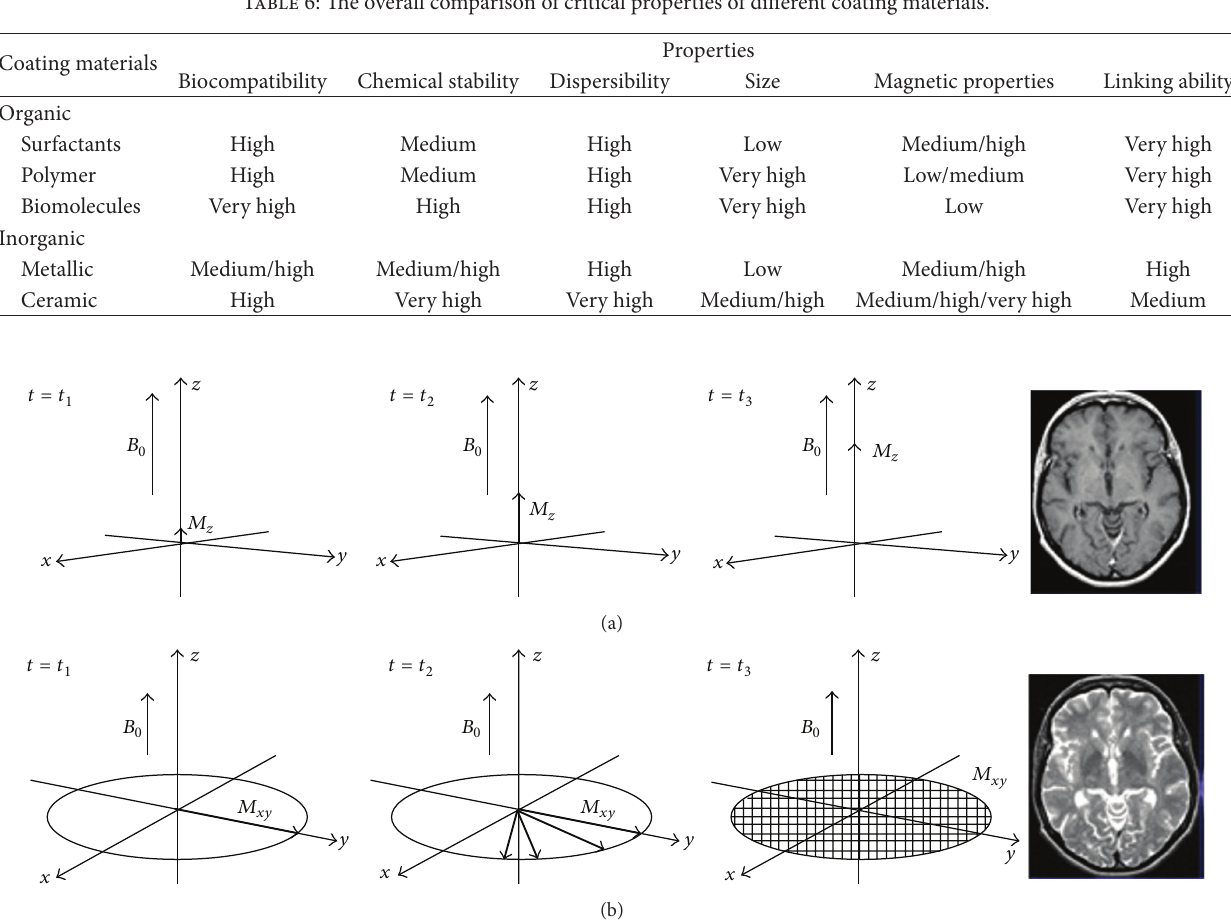
Table 6: The overall comparison of critical properties of different coating materials.